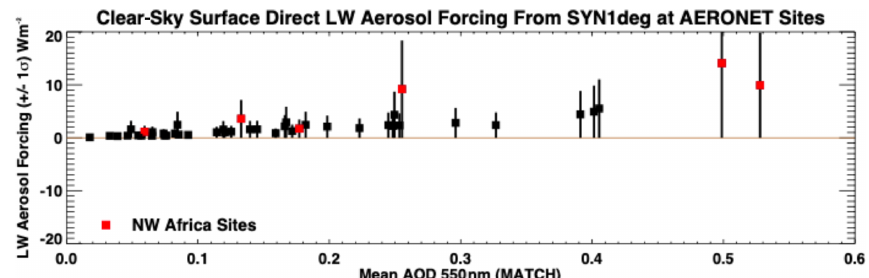
Figure 15. The clear-sky direct radiative effect (clear minus pristine) in downward longwave irradiance averaged from 2000 through 2020, when AERONET observations are available. Boxes indicate the average, and the vertical bar is ± 1 standard deviation. Black boxes indicate all 57 AERONET sites, and red boxes indicate sites in northwestern